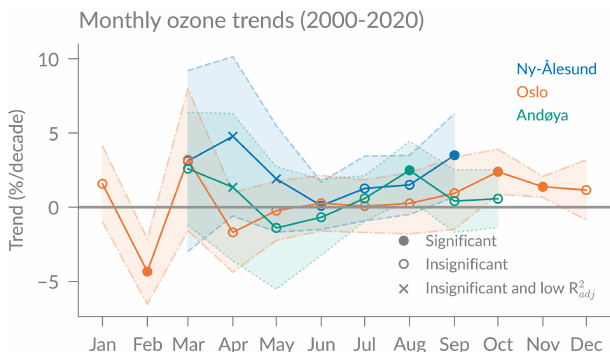
Figure 8. Monthly ozone trends in percent per decade for the three stations, with 2 σ uncertainty shadings. Filled dots represent trends that are significantly different from zero at the 95% confidence in- < 0 . 5 are marked with terval. Fits with low R 2 adj